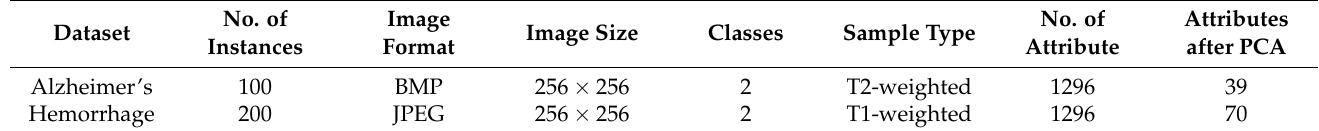
Table 1. Datasets specification.